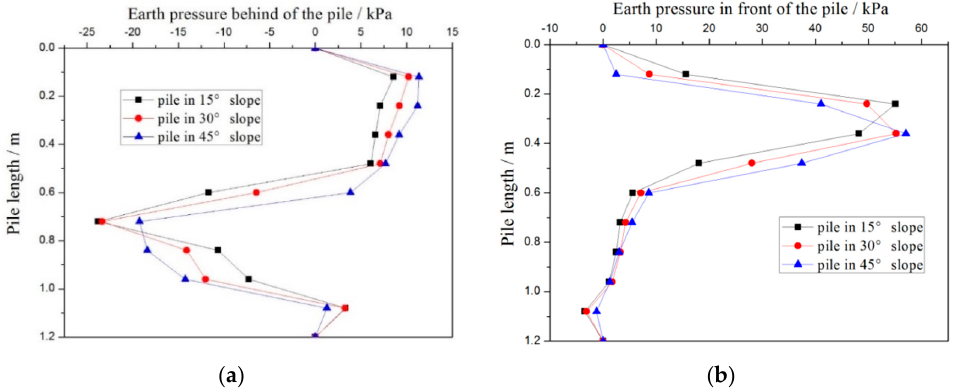
Figure 7. Soil pressure around piles under different slopes: ( a ) soil pressure behind the pile; ( b ) soil pressure in front of the pile.